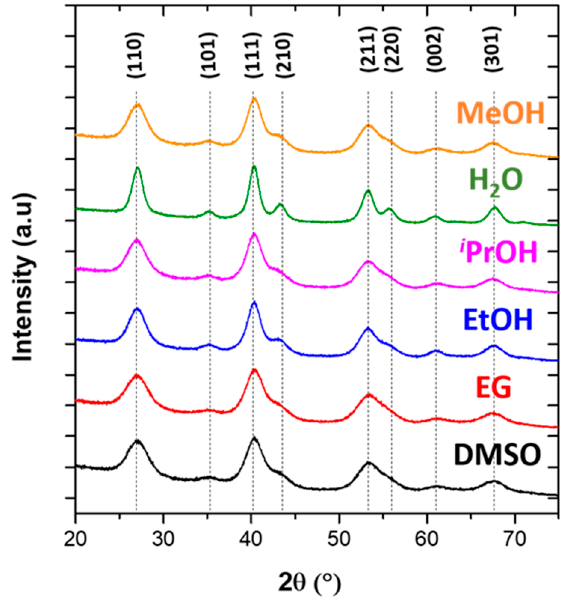
Figure 1. Figure 1. X-Ray Powder Diffraction (XRPD) patterns of MgF 2 nanoparticles prepared by microwaves- assisted solvothermal synthesis using H 2 O, i PrOH, EtOH, EG or DMSO as solvent. Table 2. Impacts of the solvent on the specific surface areas (S BET ) and particle diameters determined by XRPD (D XRD ) of the nanoparticles of MgF 2 and yield of the